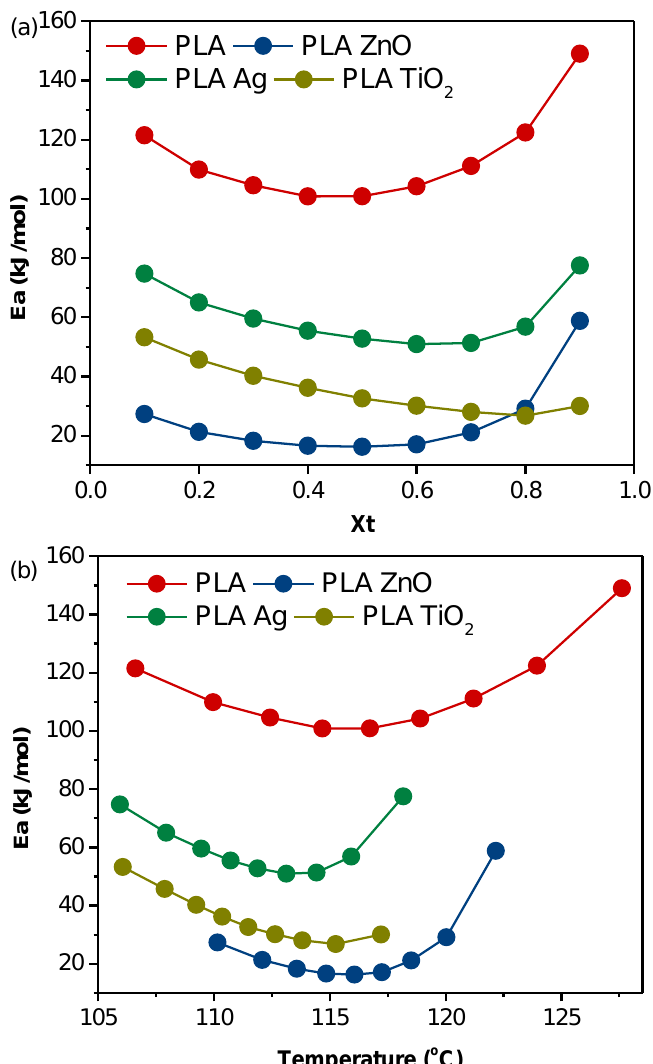
show the same trend in the reduction of E a, which follows the order: PLA > PLA Ag > PLA TiO 2 > PLA ZnO, regardless of the temperature and the conversion.